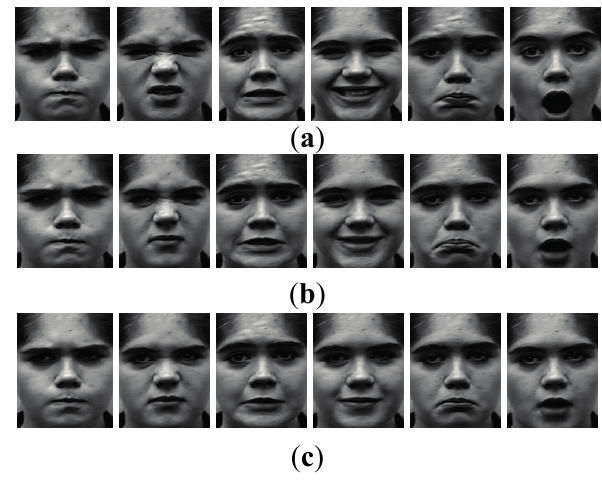
Figure 8. Multi-intensity example of six expressions: Angry, Disgust, Fear, Happy, Sad, Surprise. ( a ) High intensity; ( b ) Moderate intensity; ( c ) Low